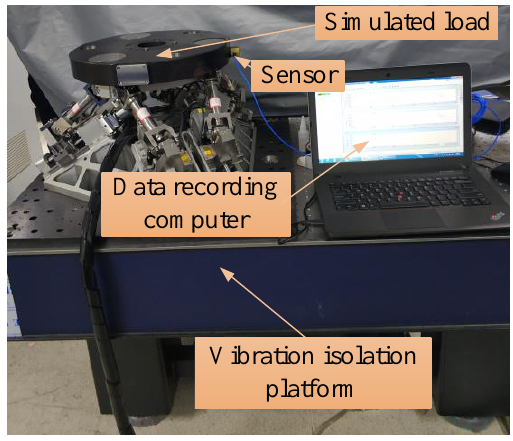
( c ) Figure 17. Finite element simulation of the third mirror adjustment mechanism: ( a ) Equivalent finite element model of subchain; ( b ) Finite element model of the whole mechanism; ( c ) Result of the finite element modal analysis. To measure the natural frequency of the parallel platform at the zero position with